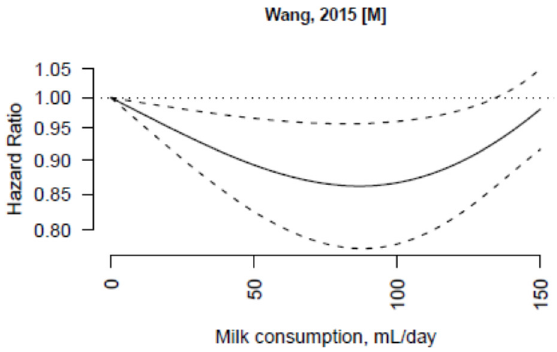
Figure 4. Dose-response association between non-fermented milk consumption and cancer mortality in individual studies. The hazard ratios are plotted on a log